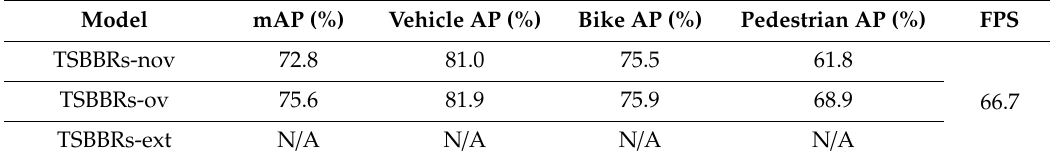
Table 5. The mAP of di ff erent overlapping criterion of conditional back-propagation mechanism, where nov denotes the non-overlapping case, ov denotes the overlapping case, and ext denotes the extreme